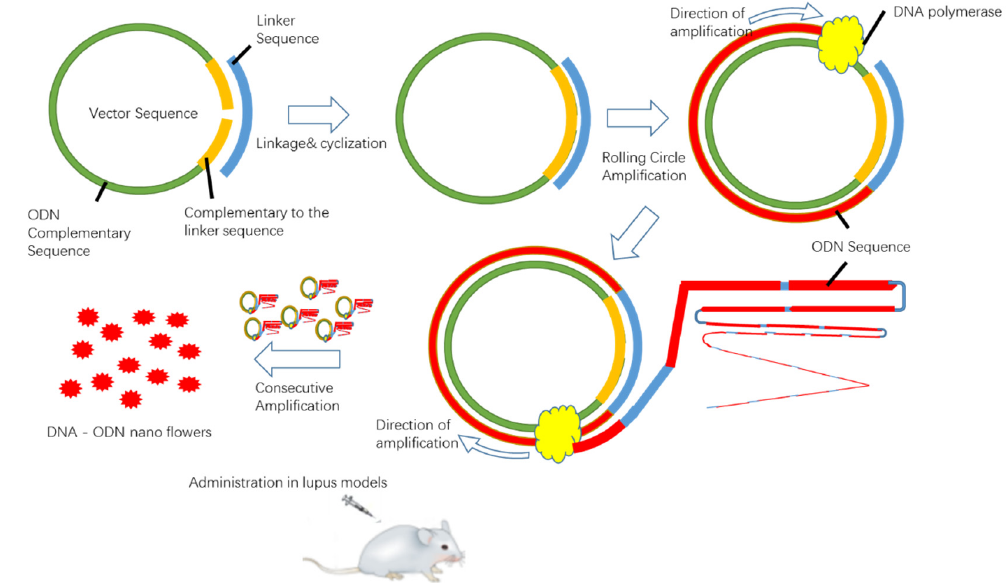
Figure 8. Schematic diagram of the preparation process of DNA nanoflowers.